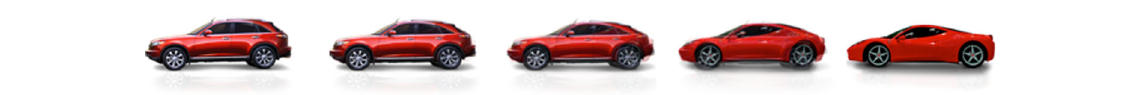
Fig. 7 Morphing result. Morphing a family car to a sports car automatically through mean value coordinates from a segmentation with the CAC (initial image from http://www.wellclean.com/wp-content/themes/artgallery_3.0/images/car1.png, final image from http://clipart-library.com/